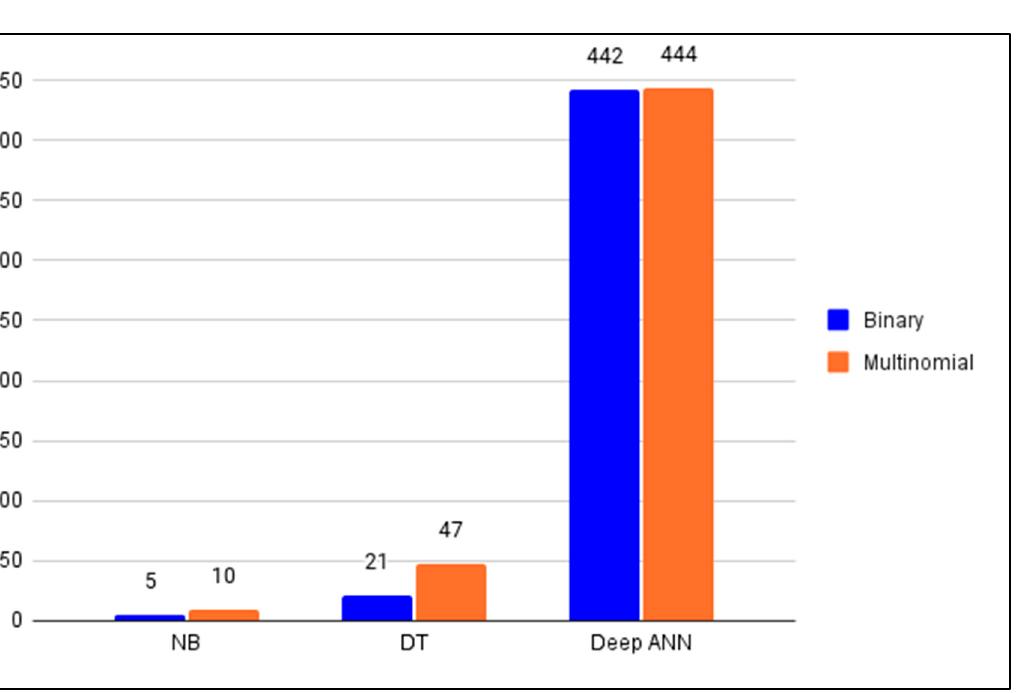
Figure 11. Anomaly detectors’ prediction time (in seconds). In the case of the binary classification; by taking into consideration Table 12, Figures 10 and 11; it can be inferred that the NB-based anomaly detector must be preferred in SDWSNs where the memory size of the controller is limited (e.g., small scale or low-power SDWSNs in an African hospital) [3,88]. It should be emphasized that since the higher is the memory size of an anomaly detector the more the controller is energy-intensive, then